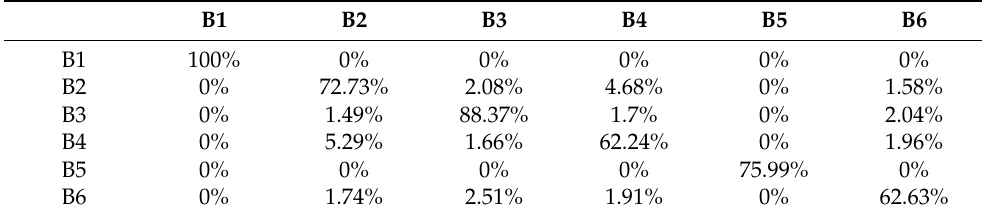
Table 4. Compatibility ratio for the Intel MAX10 x 4 + x 3 +